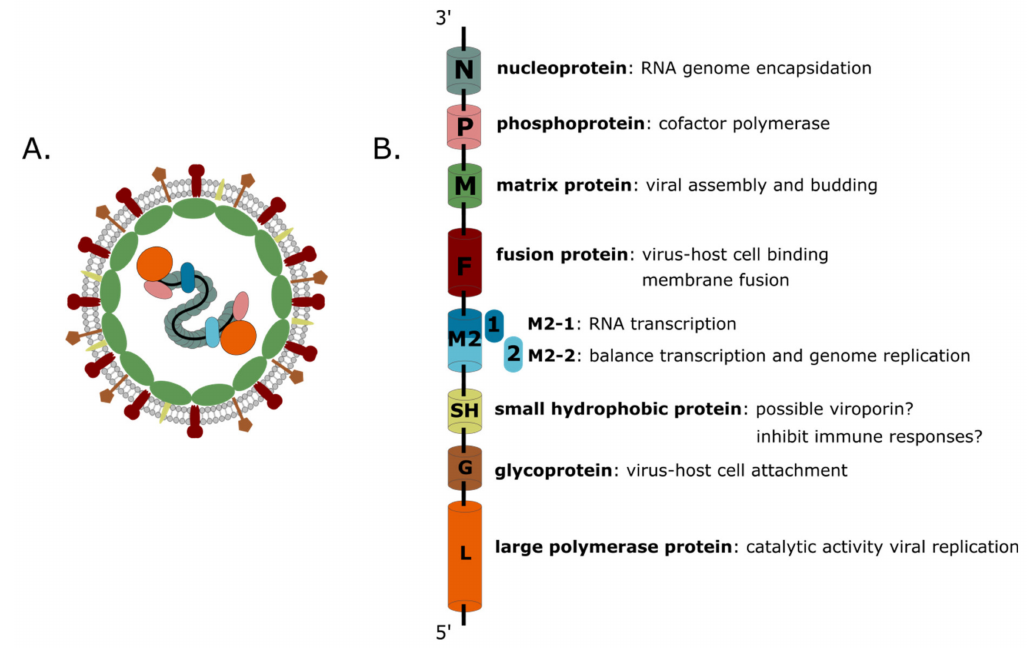
Figure 1. Human metapneumovirus (hMPV) virion structure with viral proteins and their function. Schematic representation of the hMPV viral particle ( A ) and viral genome with encoded proteins ( B ): nucleoprotein (N), phosphoprotein (P), matrix protein (M), fusion protein (F), matrix-2 proteins (M2-1 and M2-2), small hydrophobic (SH) protein, glycoprotein (G), and large (L) polymerase